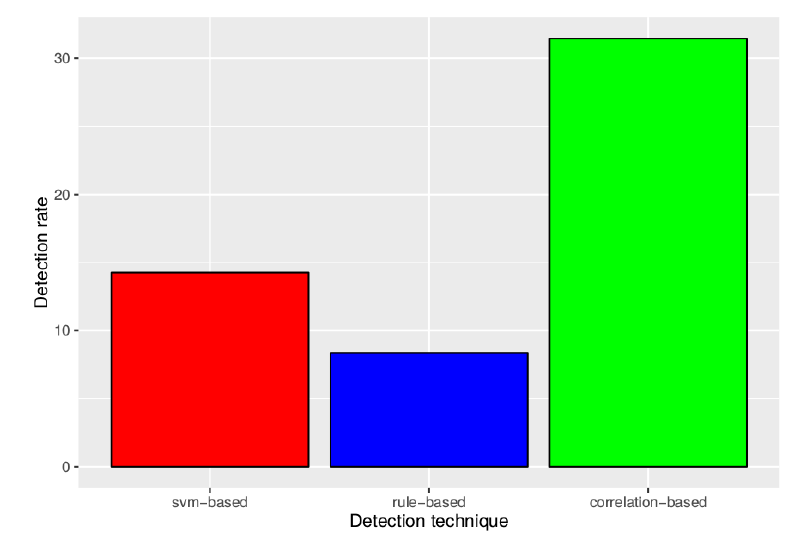
Figure 8. Detection rate comparison between the three techniques at a 5% false positive